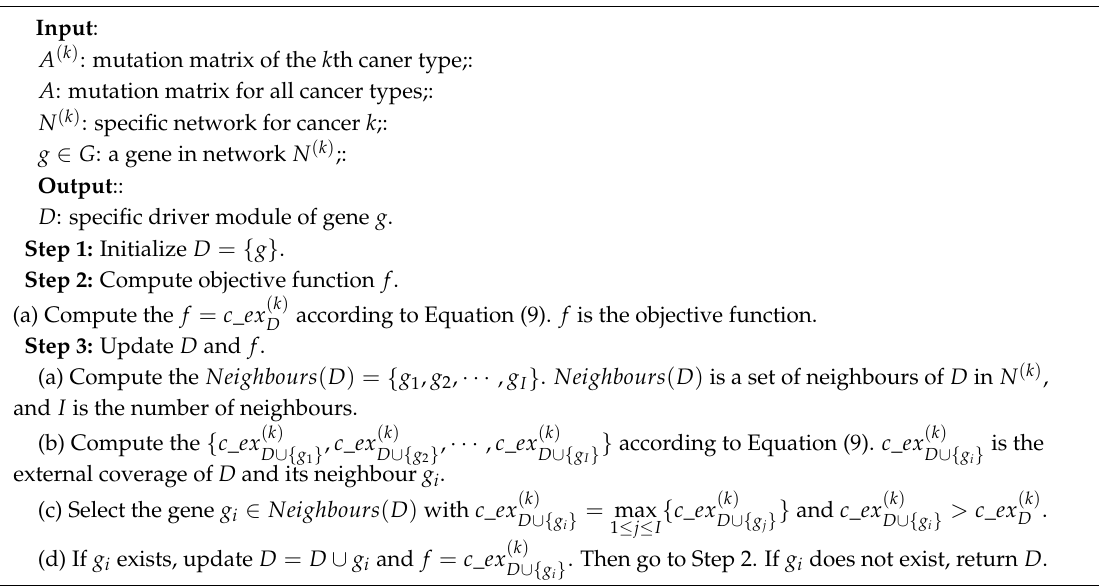
Algorithm 1 Cancer specific driver modules